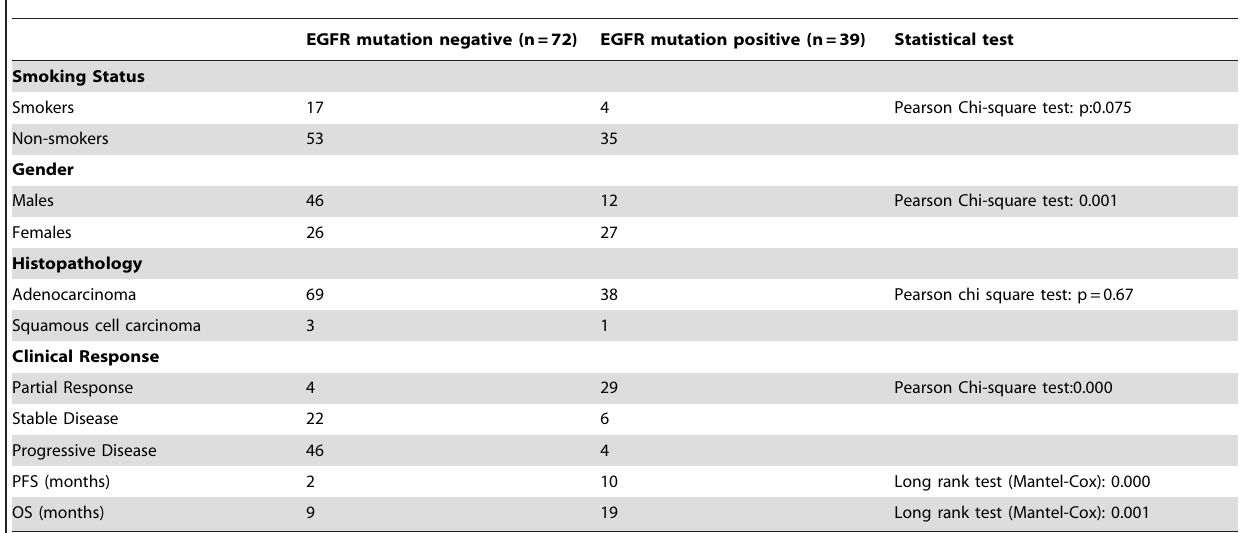
Table 2. EGFR mutation status of the patients with clinical correlation.